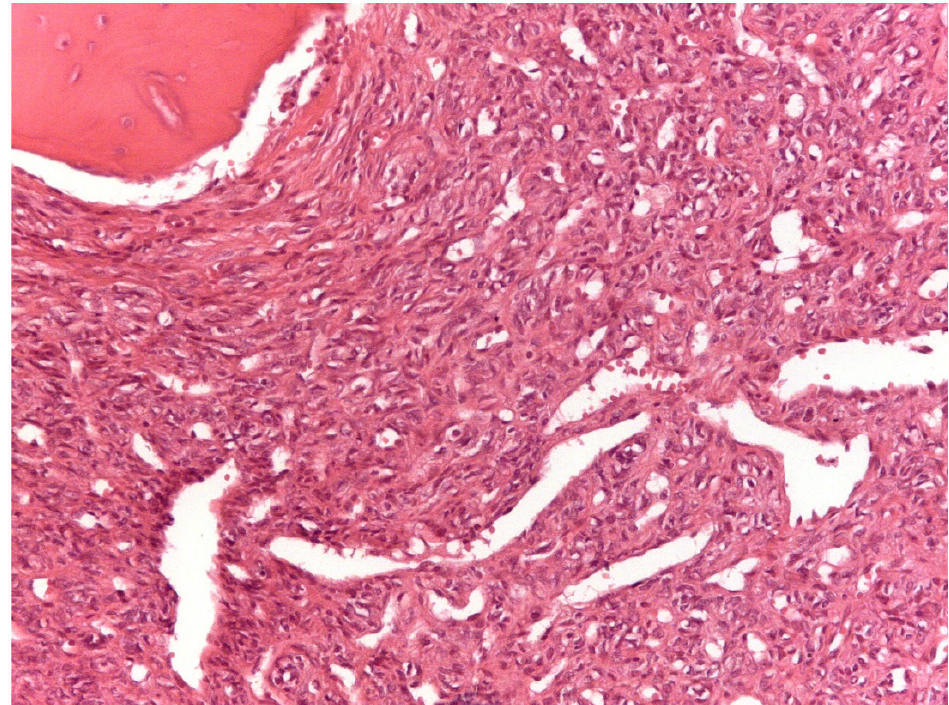
Figure 1. Solitary fibrous tumor: A spindle cell proliferation showing hemangiopericytoma-like blood vessels is seen (Hematoxylin &Eosin, original magnification, ×100).